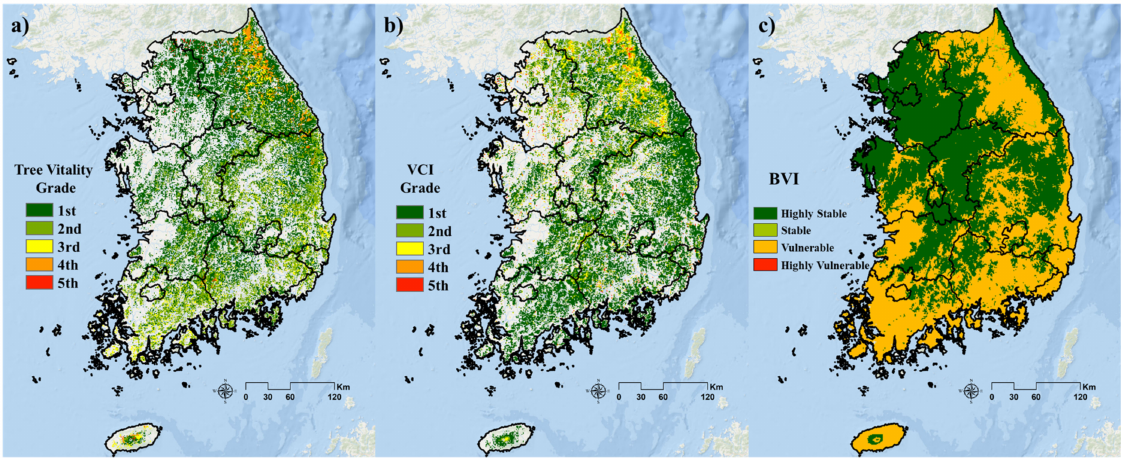
Figure 5. ( a ) MME tree vitality map extracted only from forested areas; ( b ) VCI; and ( c )